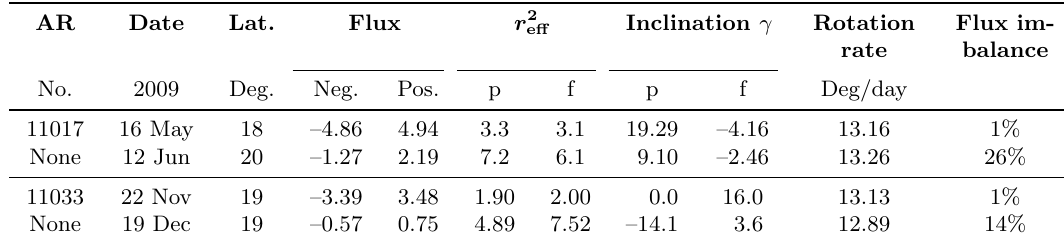
Table 3: Magnetic characteristics of two decaying ARs, measured over two consecutive rotations, adapted from Karachik et al. (2010). Magnetic flux is given in units of 10 22 Mx, 𝑟 2 rotation rate is measured with an error of ≤ 0 . 062